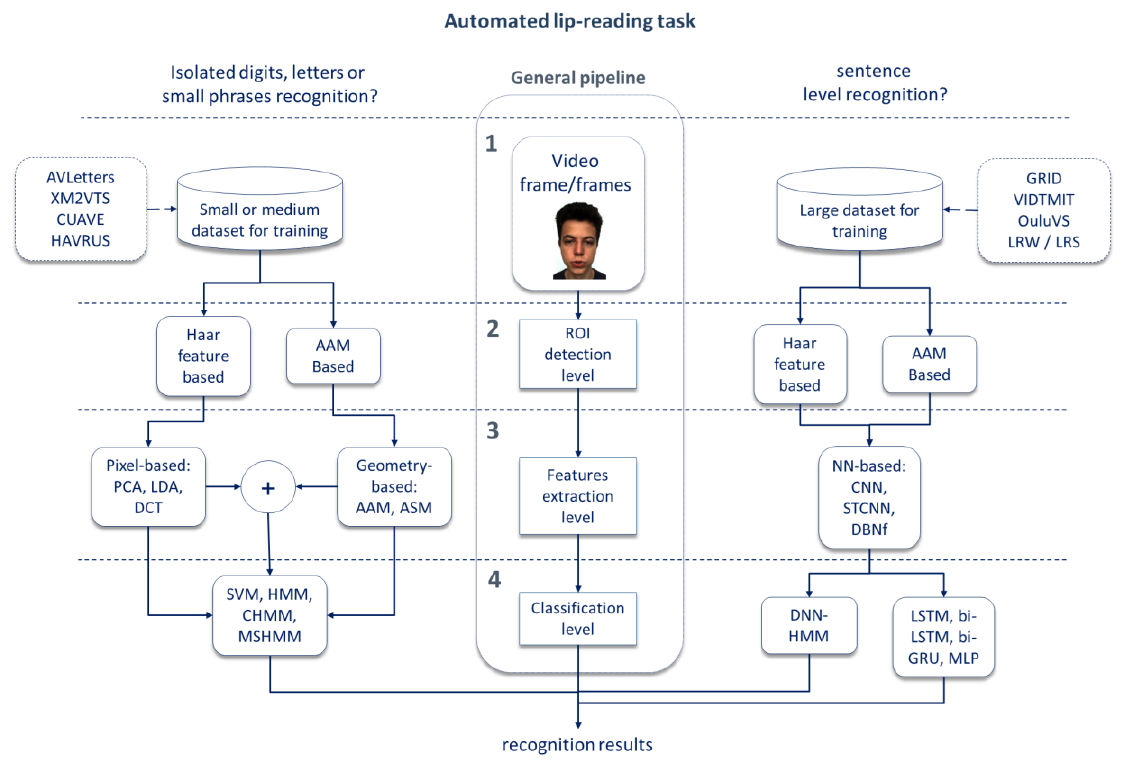
Figure 2 – Proposed task-oriented approach toward practical lip-reading system